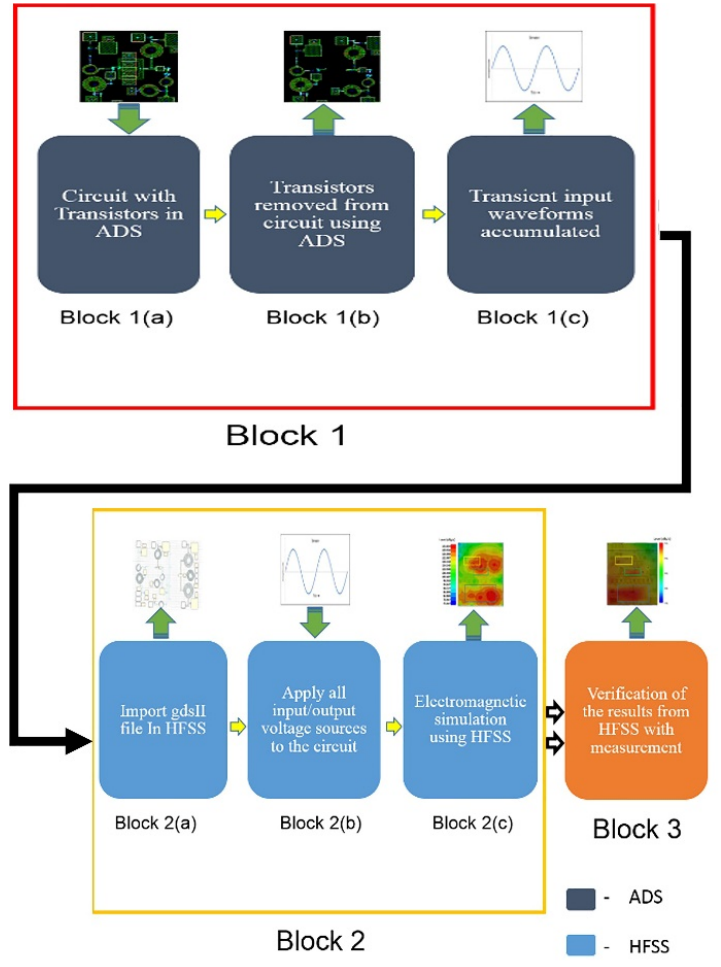
Figure 3. Flow chart of the methodology followed for simulation [28]. ADS, advanced design system; HFSS, high frequency structure simulator.